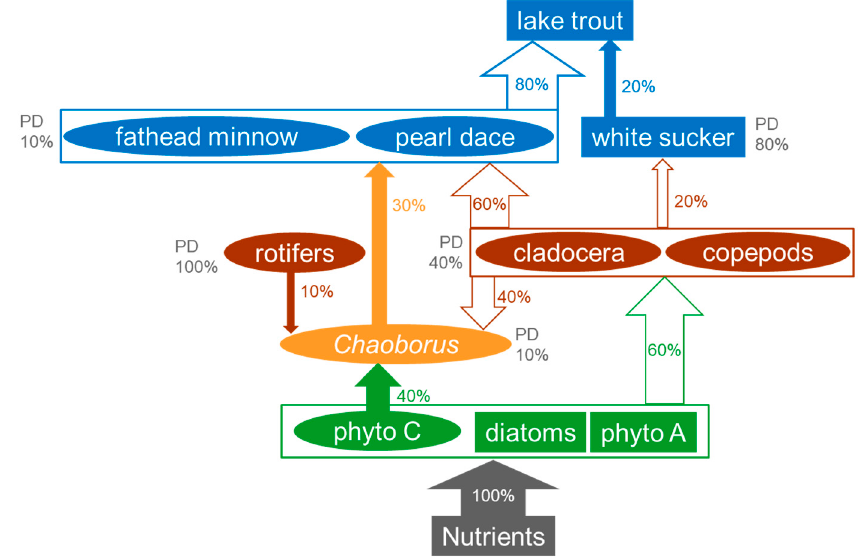
Figure 19. Dependence diagram of the studied freshwater food web after adding Chaoborus to the ecosystem model. The percentages represent the feeding preferences (abbreviations: PD = particulate detritus; legend: filled arrows: transfer from one group, open arrows: transfer from multiple groups).